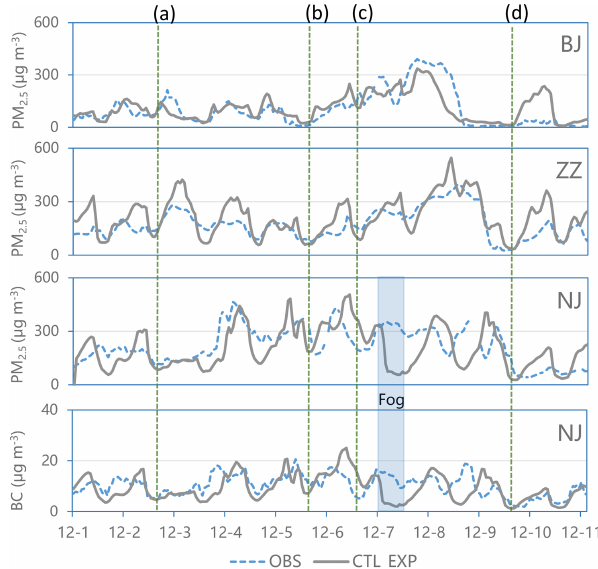
Figure 4. Temporal variation of surface aerosol concentration in Beijing (BJ), Zhengzhou (ZZ) and Nanjing (NJ). Observational data (blue dashed line) of PM 2 . 5 are from CNEMC and observational data of BC are from SORPES in NJ. The simulated results are from EXP_CTL. The vertical green dashed lines labeled (a) – (d) denote the corresponding time as in Fig. 3a–d. The blue area denotes the duration of fog episode in the YRD